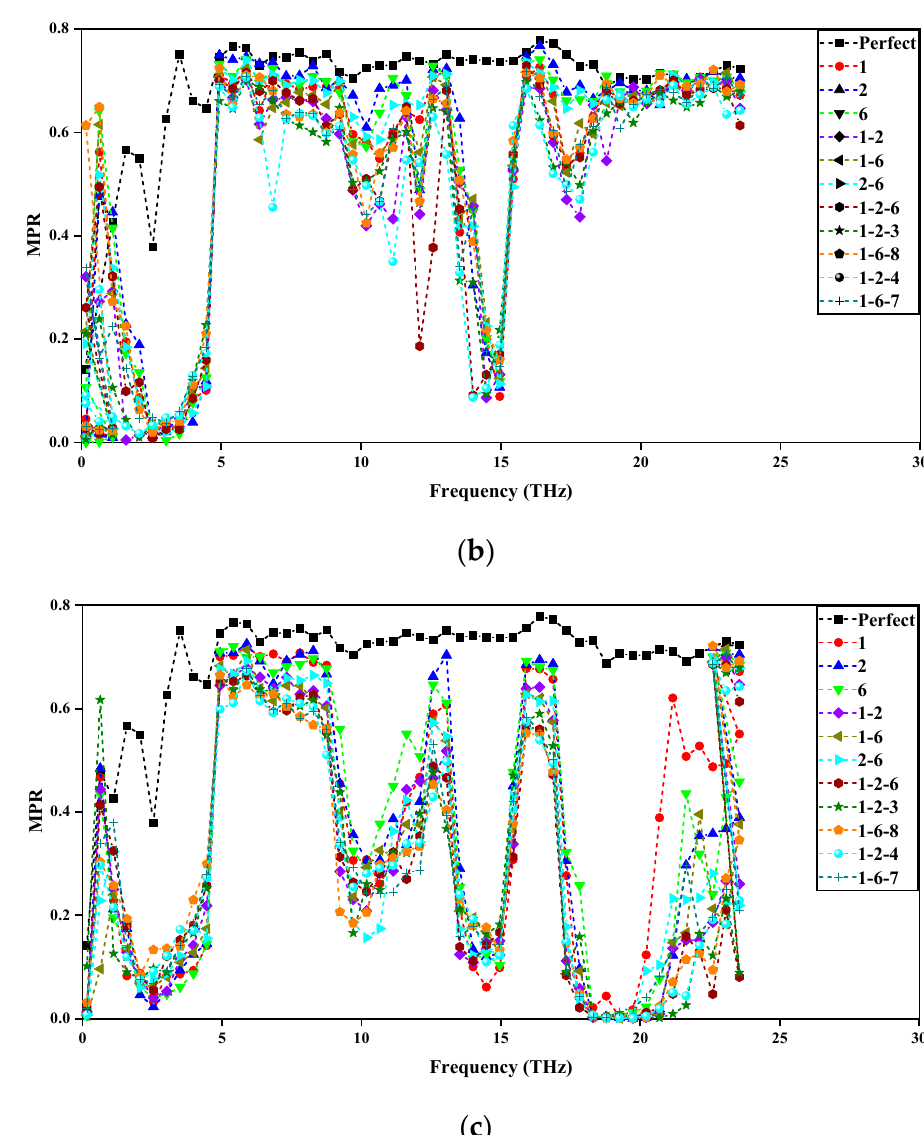
Figure 6. MPR: ( a ) concave; ( b ) perforation; ( c ) amorphous. The numbers represent small block labels. The calculation results are discrete frequency points. To better display the results, the frequency points are connected by dotted lines.